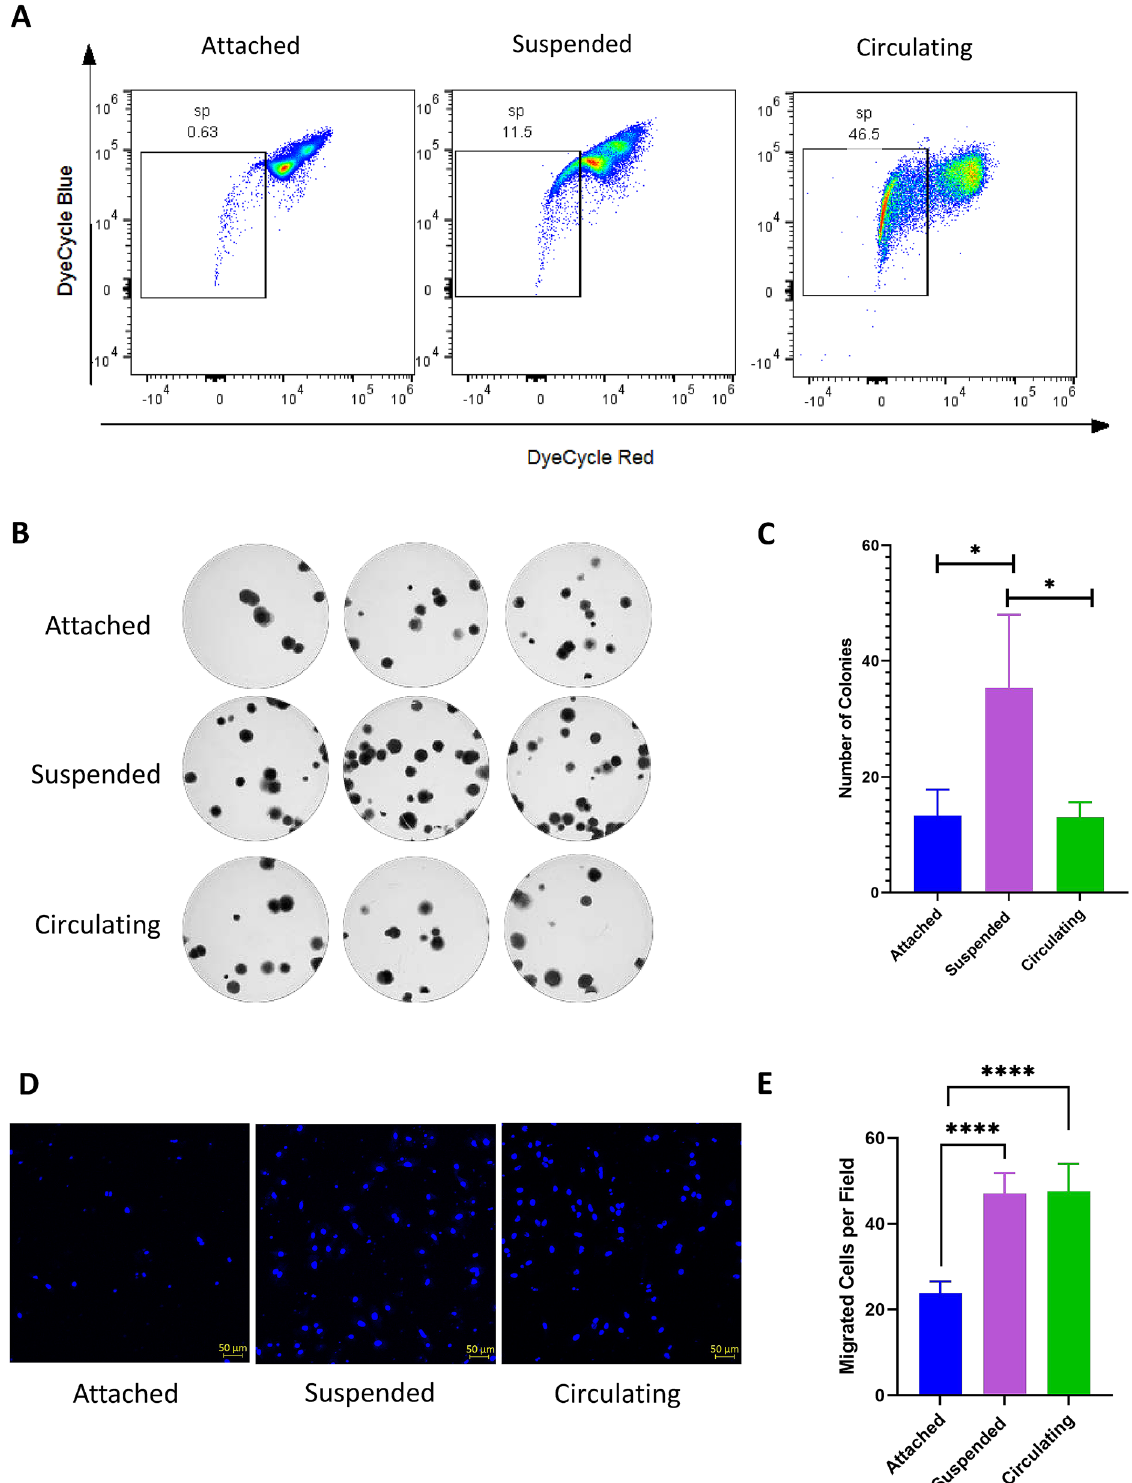
Figure 6. Circulation induces the enrichment of side population cells (SPCs) and increases lung cancer cell migration but does not alter cell clonogenicity. ( A ) Primary lung adenocarcinoma cells were stained with Vybrant DyeCycle Violet to determine dye effluxing side population cells. The percentage of SPCs was significantly higher in circulating cells as compared to attached cells and cells in suspension ( B , C ) Colony formation assay was performed to evaluate clonogenicity. The number of clonogenic colonies in circulating cells was not significantly different from attached cells but cells in suspension showed a higher number of colonies as compared with attached and circulating cells ( p = 0.005). ( D , E ) Transwell migration assay showed that cells subjected to suspension and circulation presented higher invasive and migratory potentials than attached cells ( p < 0.001). Representative microscopy image of DAPI staining for the 3 conditions ( D ) and statistical results of the mean ± SD ( E ). **** p <